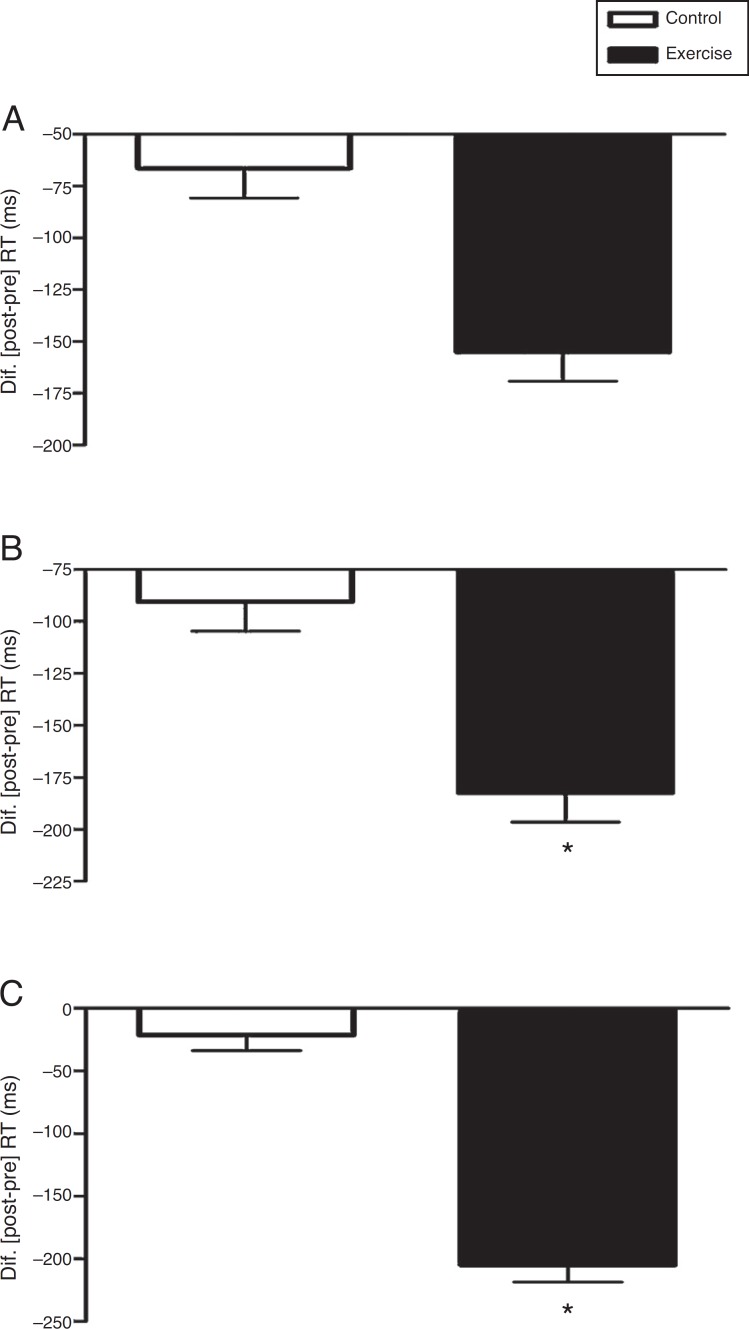
Acute effect of vigorous aerobic exercise on the reaction time (RT) in Phases 1 (A), 2 (B) and 3 (C) of the computerized Stroop Test (Testinpacs®). Split-Plot Anova adjusted for chronological age was applied in the intra- and inter-comparisons between conditions (2×2). The delta data (Δ = post-pre) are shown as mean and standard error. *p<0.001; pre × post.